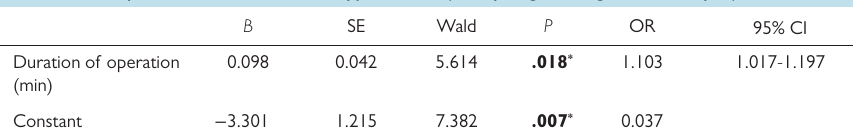
Table 2. Independent Risk Factors for Hypothermia (Binary Logistic Regression